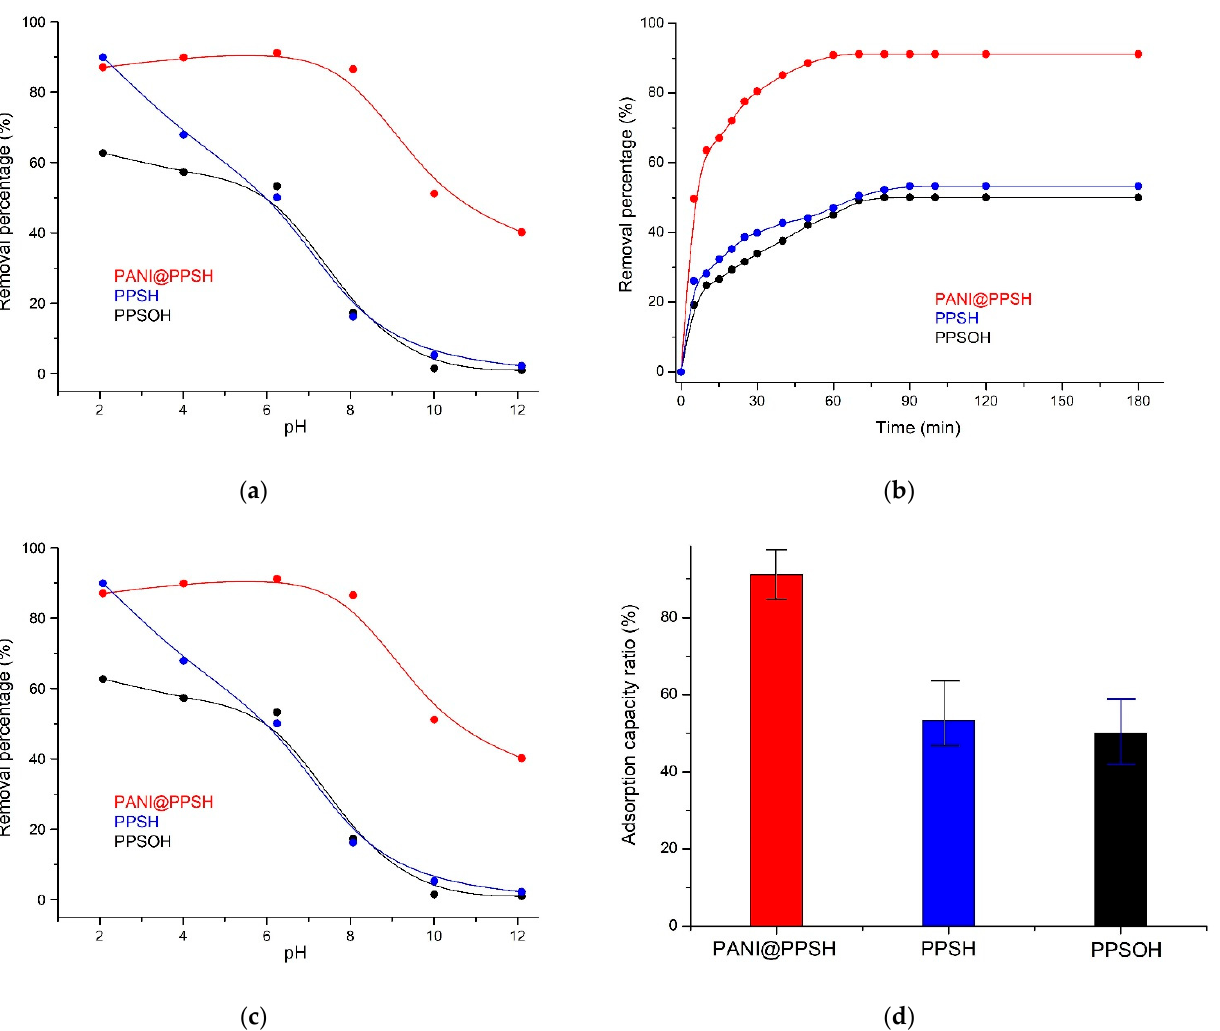
Figure 5. ( a ) Influence of pH on CR adsorption, ( b ) effect of contact time, ( c ) adsorption isotherm, and ( d ) comparison of adsorption efficiency of adsorbents (C0: 20 mg · L − 1 ; adsorbents dose: 0.1 g; and ( d ) comparison of adsorption efficiency of adsorbents (C0: 20 mg·L − 1 ; adsorbents dose: 0.1 g; CR: 100 mL; T: 298 K; pH = CR: 100 mL; T: 298 K; pH = 6.5).